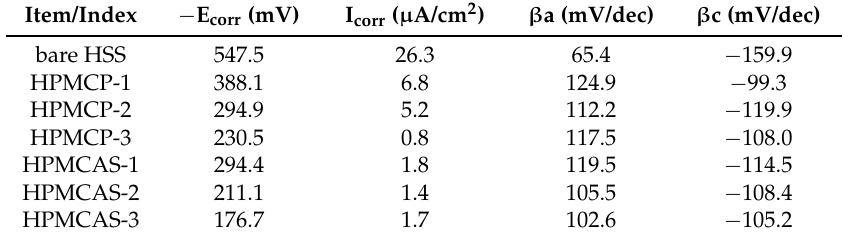
Table 4. Electrochemical corrosion measurement of HSS, HPMCP and HPMCAS coated electrodes. Item/Index